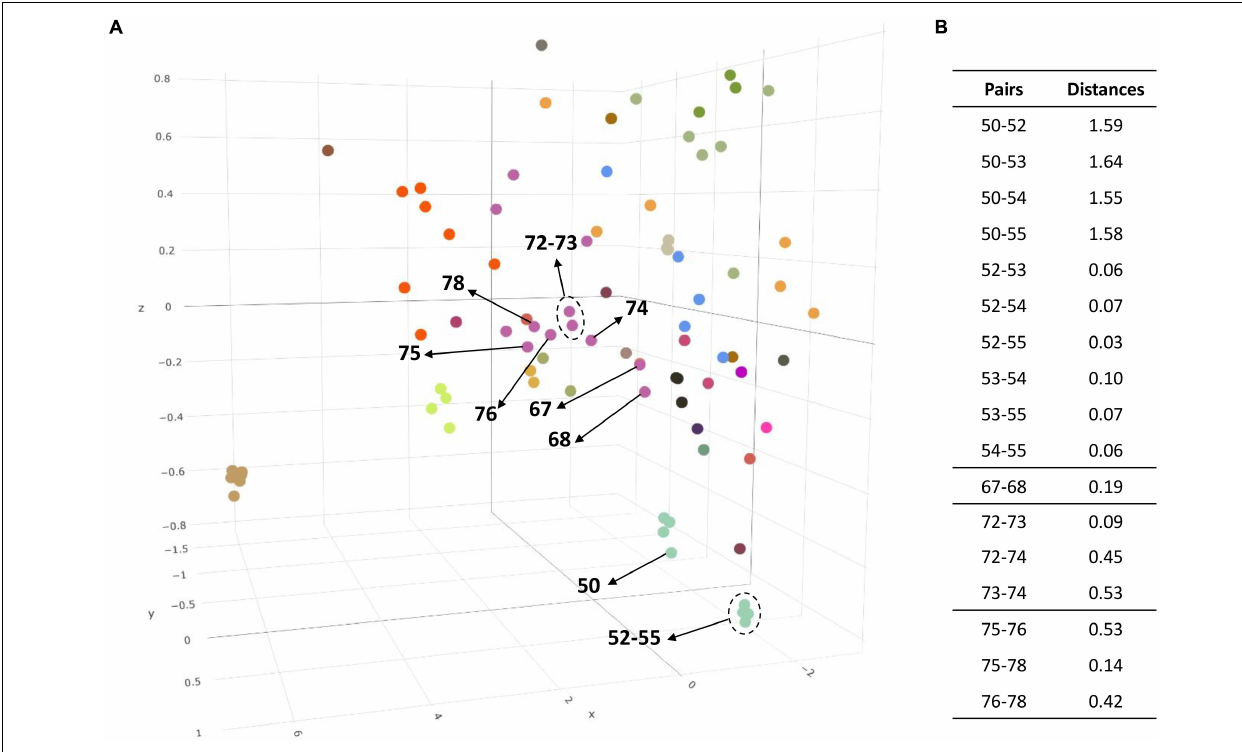
FIGURE 3 | (A) 3D plot of the three major axes generated by principal component analysis (PCA) of the RSCU values. The RSCU of each strain except for the 5 codons of Met, Trp, and Stop codons were plotted after PCA analysis. In this scatter plot, the same color indicates the same genus and the label of each dot can be found in the accompanying.html file. (B) The distance on the PCA plot between the existing group and the strain to be reported as a novel species. 50, Ntd. vulgaris Miyazaki F; 52, Ntd. vulgaris DP4; 53, Ntd. vulgaris NBRC 13699; 54, Ntd. vulgaris RCH1; 55, Ntd. vulgaris Hildenborough T ; 67, Dsv. piger ATCC 29098 T ; 68, Dsv. piger FI11049; 72, Dsv. legallii H1 T ; 73, Dsv. legallii AM18-2; 74, Dsv. legallii KHC7; 75, Dsv. desulfuricans DSM 642 T ; 76, Dsv. desulfuricans IC1; 78, Dsv. desulfuricans ATCC